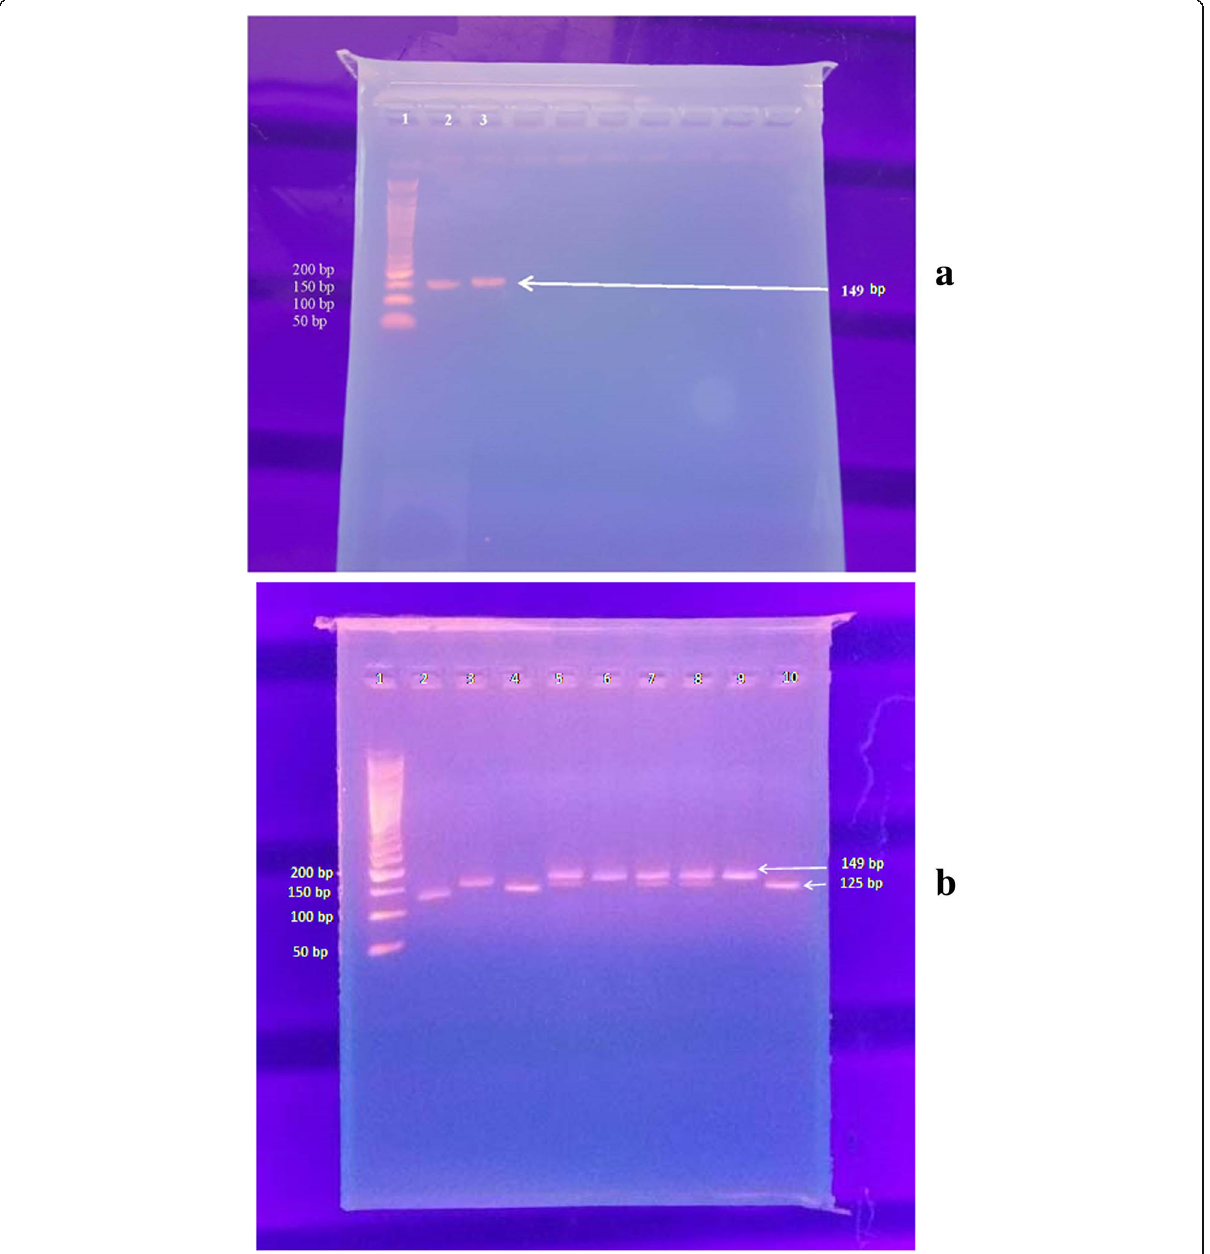
Fig. 1 a Agarose gel electrophoresis for miR-196a2 gene amplification bands correspond to ladder band size (149 bp). b Agarose gel electrophoresis showing PCR-RFLP analysis of miR-196a2 gene after addition restriction enzyme (MspI). Lanes (ladder): lanes 3, 6, and 9 (TT) band (149); lanes 5, 7, and 8 (TC) band (149,125, and 24 bp); and lanes 2, 4, and 10 (CC) band (125 and 24